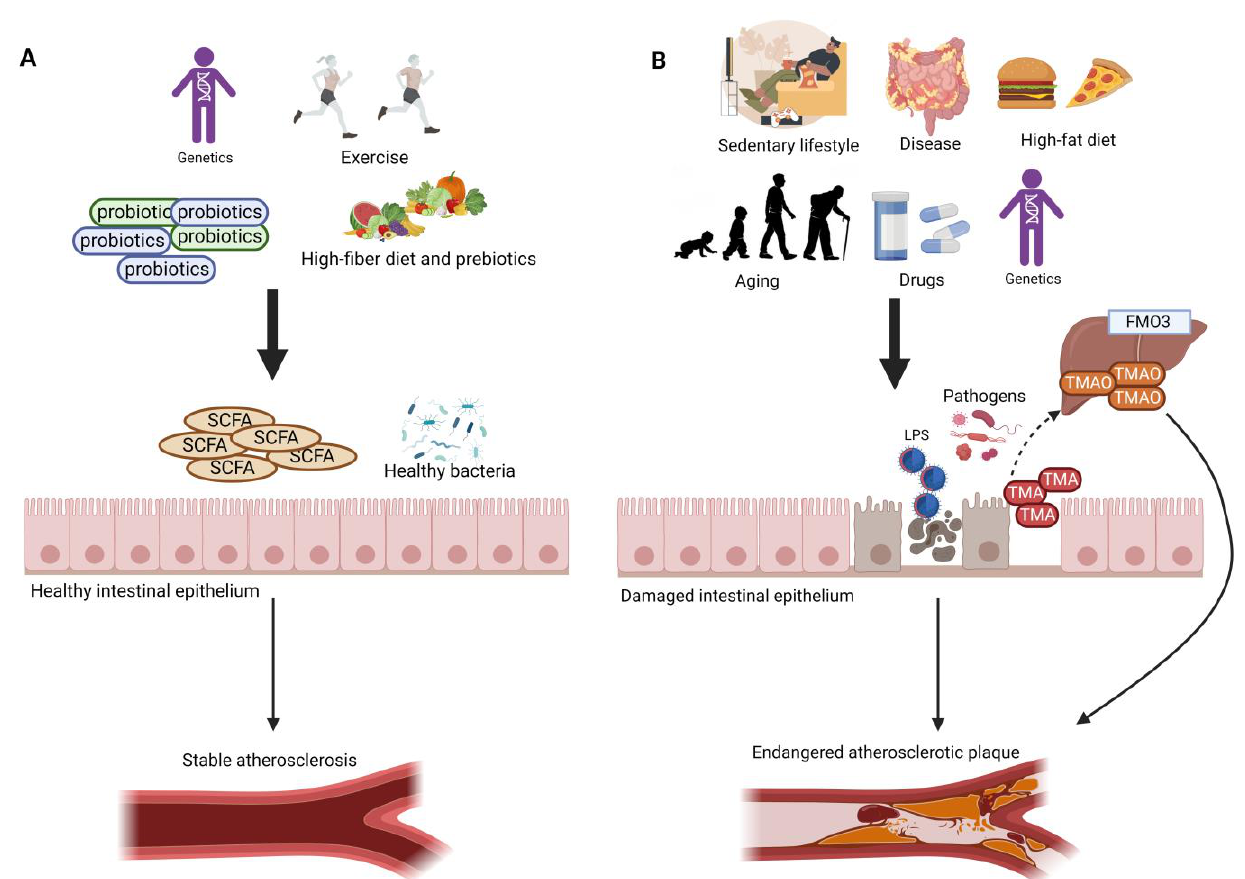
Figure 1. Different factors, such as the gut microbiome, diet, lifestyle, and genetics, play a major role in the development of atherosclerosis. ( A ) High-fiber diet, active lifestyle, and the intake of probiotics increase the abundance of beneficial gut bacteria and the amount of SCFAs, which support the tight junctions and protect the intestinal epithelium, thus preventing harmful metabolites from entering the circulation. This contributes to a stable atherosclerotic plaque. ( B ) High-fat diet, sedentary lifestyle, intestinal disease (e.g., Crohn’s disease, irritable bowel disease), the intake of different drugs (e.g., antibiotics), and aging lead to a disruption in the gut microbial profile, resulting in higher abundance of pathogenic bacteria and lower amounts of SCFAs. These effects lead to damage in the gut epithelium; thus, a leaky gut allows the translocation of LPS, TMA, and other damaging metabolites into the circulation. High amounts of plasma LPS and TMAO result in an endangered atherosclerotic plaque.